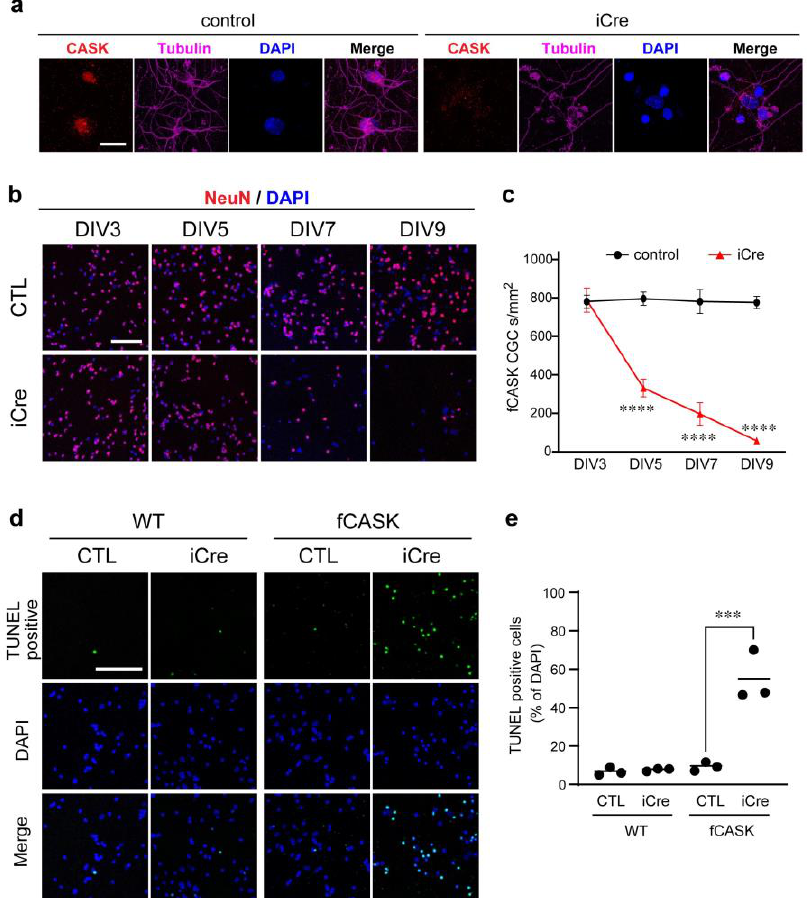
Figure 2. CASK is essential for the survival of cultured CG cells. ( a ) Lentivirus-iCre-mediated CASK KO in cultured CG cells. Cultured homozygote floxed CASK (fCASK) CG cells were infected with lentivirus-iCre at DIV1 and stained with antibodies against CASK and tubulin at DIV7. The CASK signal is absent in iCre-infected CG cells. Scale bars = 20 μm. ( b ) Cultured fCASK CG cells were infected with lentivirus-iCre. The cells are double stained with the antibody against NeuN (red) and DAPI (blue). ( c ) Quantification of the number of NeuN positive CG cells in ( b ) (n = 9 each). **** p < 0.0001; two-way ANOVA. ( d ) TUNEL analysis of CG cells. Cultured wild-type (WT) or fCASK CG cells are infected with lentivirus-iCre. Cells are stained using the In situ Cell Death Detection Kit (green) and DAPI (blue). Scale bar = 100 μm. ( e ) Quantification of TUNEL-positive cells in ( d ). All values present the mean. Each dot in the graph represents the average density of randomly selected three areas in each well. n = 3 (wells) in each group. Five to eight mouse brains were collected for preparing CG cell cultures to aliquot into each well. *** p < 0.001; one-way ANOVA. 3.3. CG Cell Death in CASK KO Mice Is Independent of BDNF Secretion Mediated by Neurexins One of the representative functions of CASK is a scaffold of the Neurexin complex in the presynaptic terminal. Neurexin family proteins are transcribed by three genes (NRXN1, NRXN2, NRXN3). All three NRXNs produce longer α- and shorter β-forms [35– 37], and NRXN1 additionally produces the shortest γ-form [38]. The last exons of all three neurexin genes encode transmembrane regions to cytoplasmic tails that are shared be- tween α-, β-, and γ-forms. We previously generated Neurexin KO mice that remove all Neurexin isoforms by targeting the last exons of three Neurexins (Nrxn-TKO) [33]. Nrxn- TKO also shows cell death in CG cells in the culture system. This cell death was shown to be due to impaired secretion of brain-derived neurotrophic factor (BDNF). The applica- tion of BDNF in Nrxn-TKO culture rescues the cell death of CG cells [33]. To examine whether cell death of CASK KO CG cells is also attributable to depletion of BDNF, we